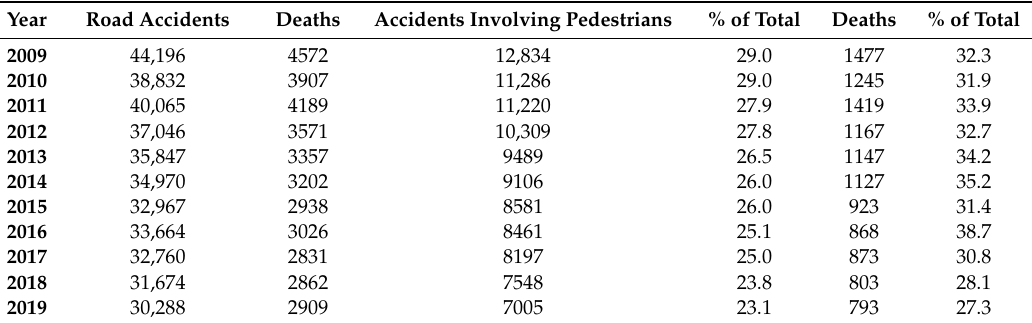
Table 1. Road accidents involving pedestrians in Poland,